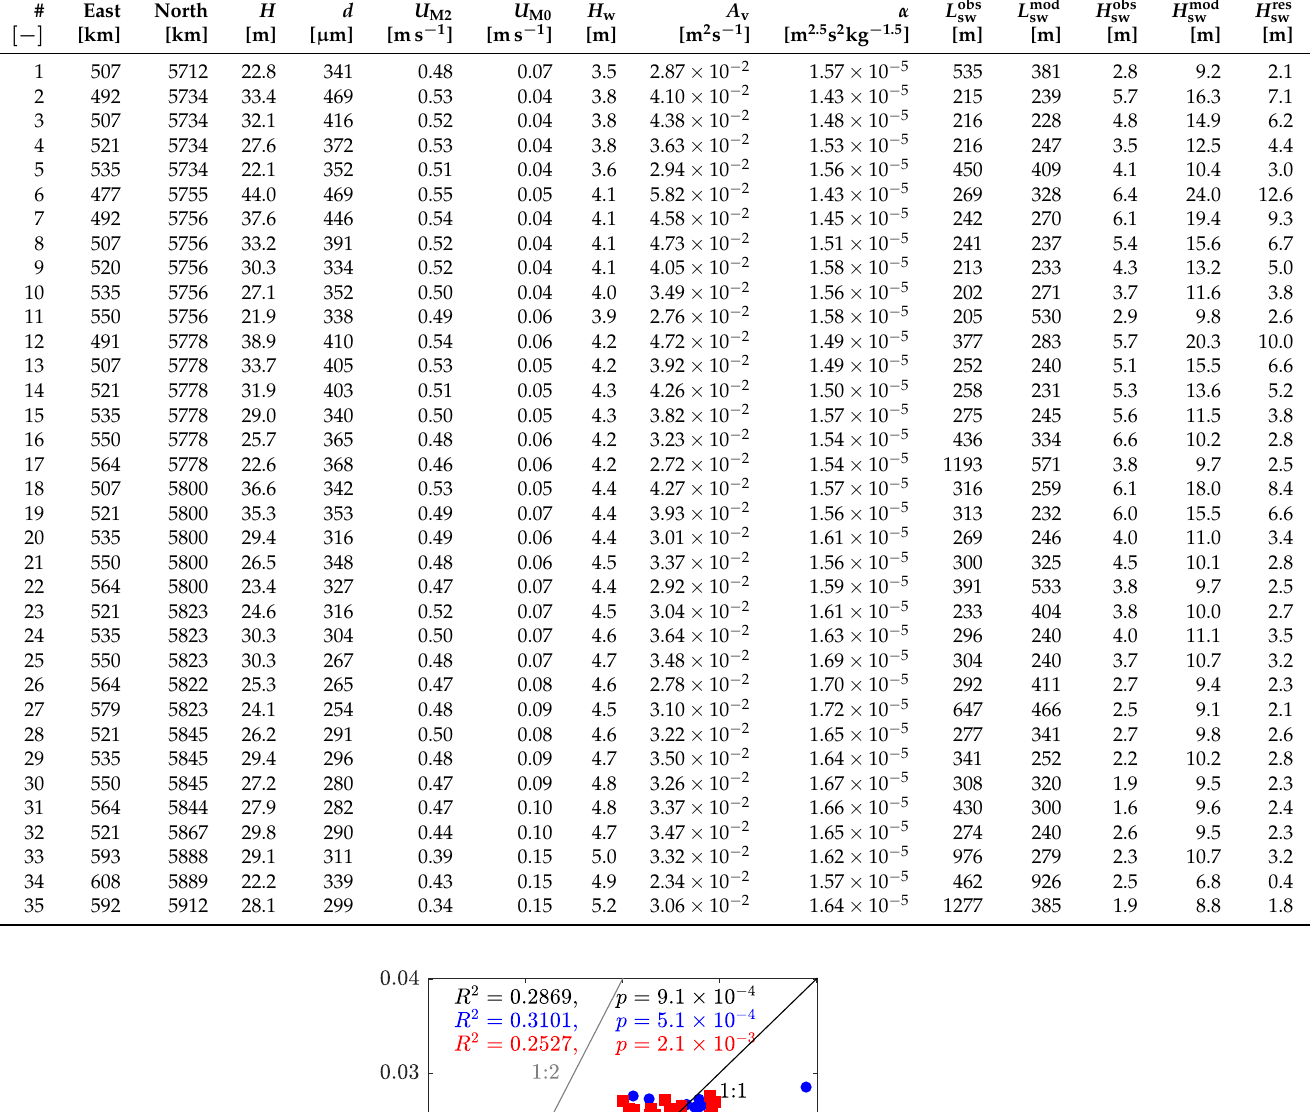
Table 3. Location-dependent quantities for the 35 validation locations: model parameters and observed vs. modeled sand wave characteristics.